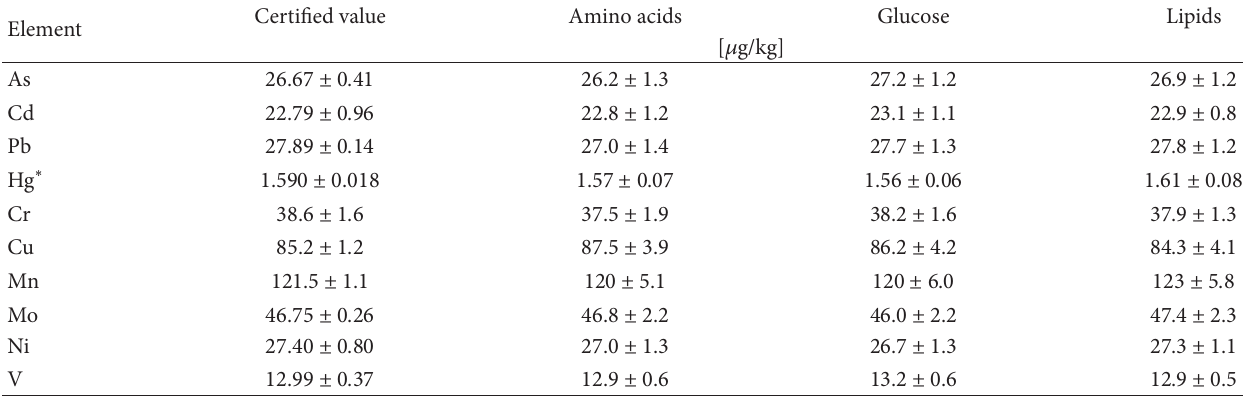
Table 3: Content of heavy metals in raw materials used in production of parenteral nutrition [26]. Element